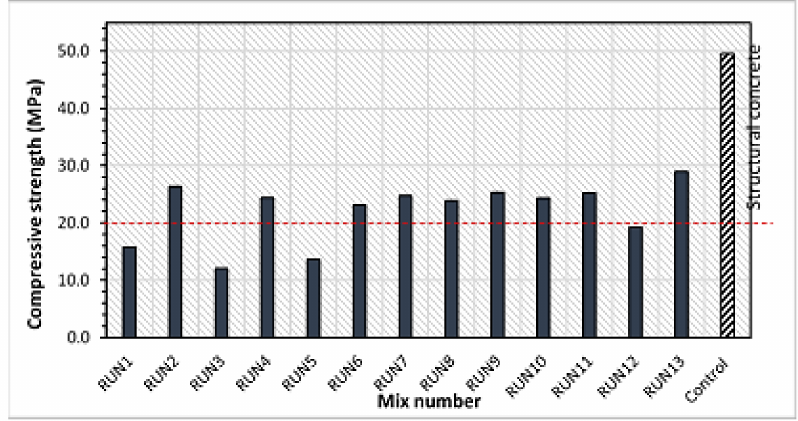
Figure 8. Compressive strength of the HVFA–CRC mixes at 28 days.